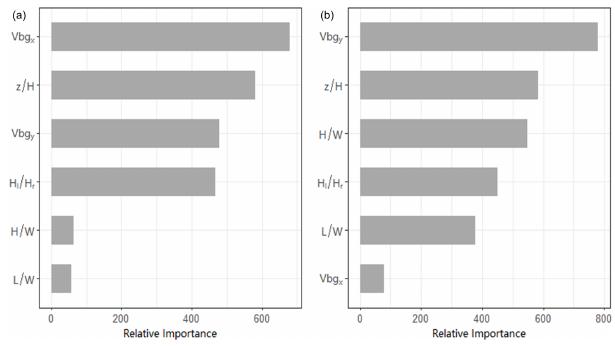
Figure 5. Performances of machine learning on the velocity pro- file in wind tunnel experiments. The street canyon was perpendicu- lar (a) or parallel (b) to the wind direction at the roof level in differ- ent experiments. The detailed description of each experiment was introduced in Sect. 2.2.3.